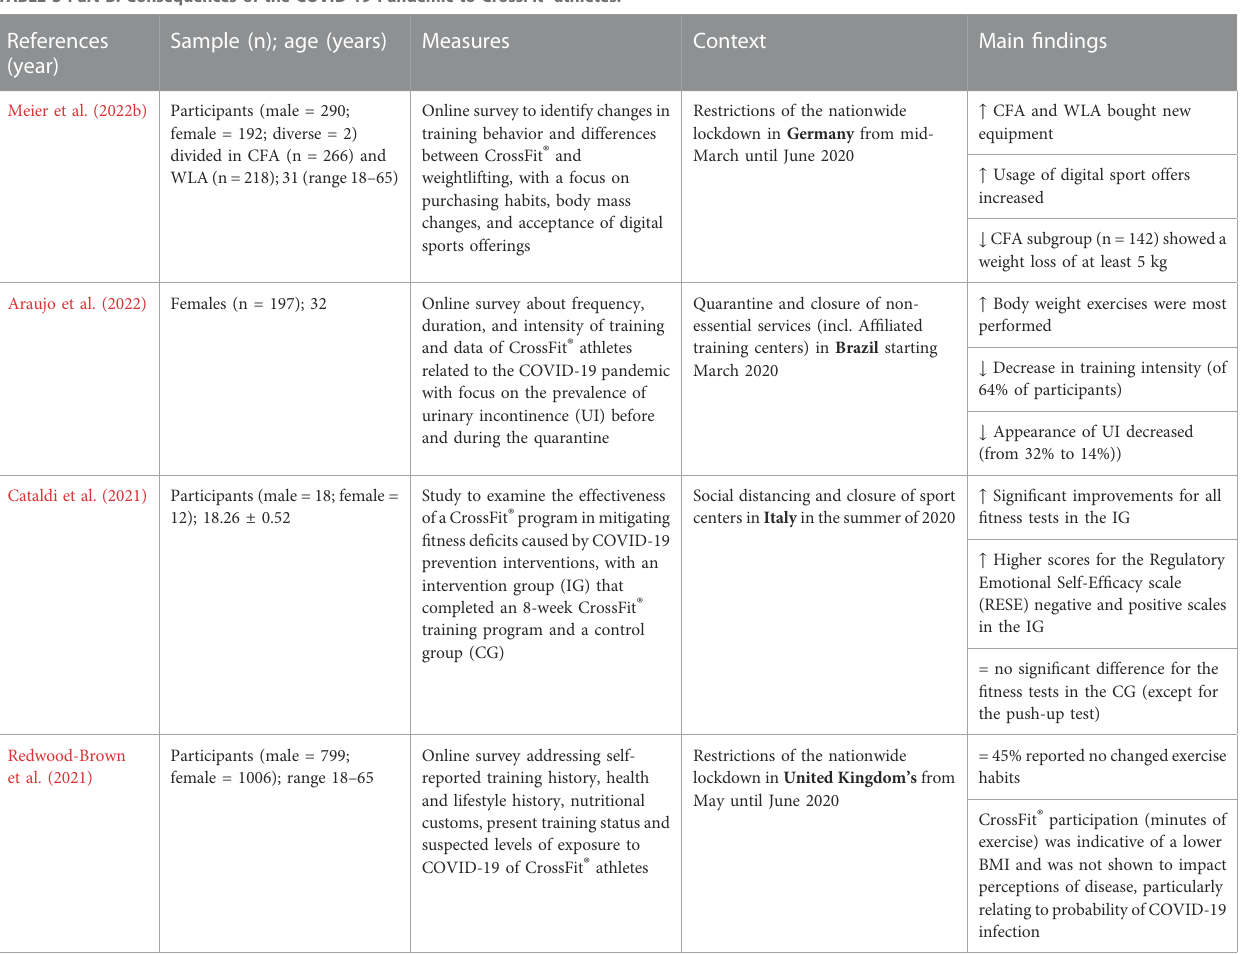
TABLE 3 Part B: Consequences of the COVID-19 Pandemic to CrossFit ®